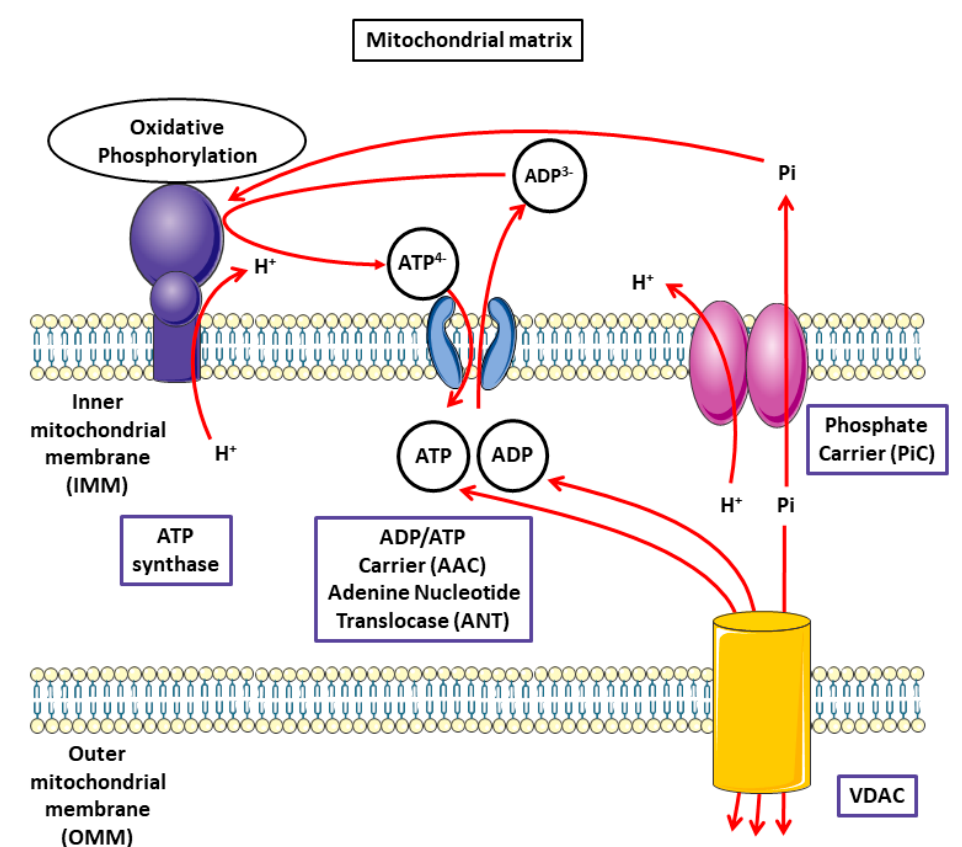
Figure 2. Schematic representation of the functions of carriers regulating the adenosine nucleotide pools. The ADP / ATP transport is characterized as an exchange of exogenous and endogenous nucleotides. ADP / ATP exchange across the inner mitochondrial membrane is catalyzed by the ADP / ATP carrier (AAC). The phosphate carrier protein and the voltage-dependent anion selective channel (VDAC) are transmembrane proteins located in the mitochondrial membrane catalyzing the transport of Pi. The process of oxidative phosphorylation permits the generatation of ATP from ADP, and Pi drives ATP synthesis by ATP synthase through H + reuptake.